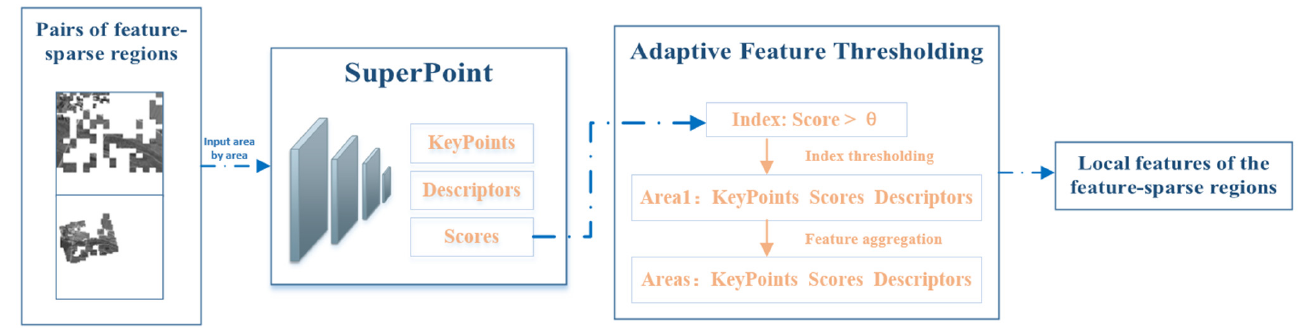
Figure 3. The adaptive thresholding algorithm.